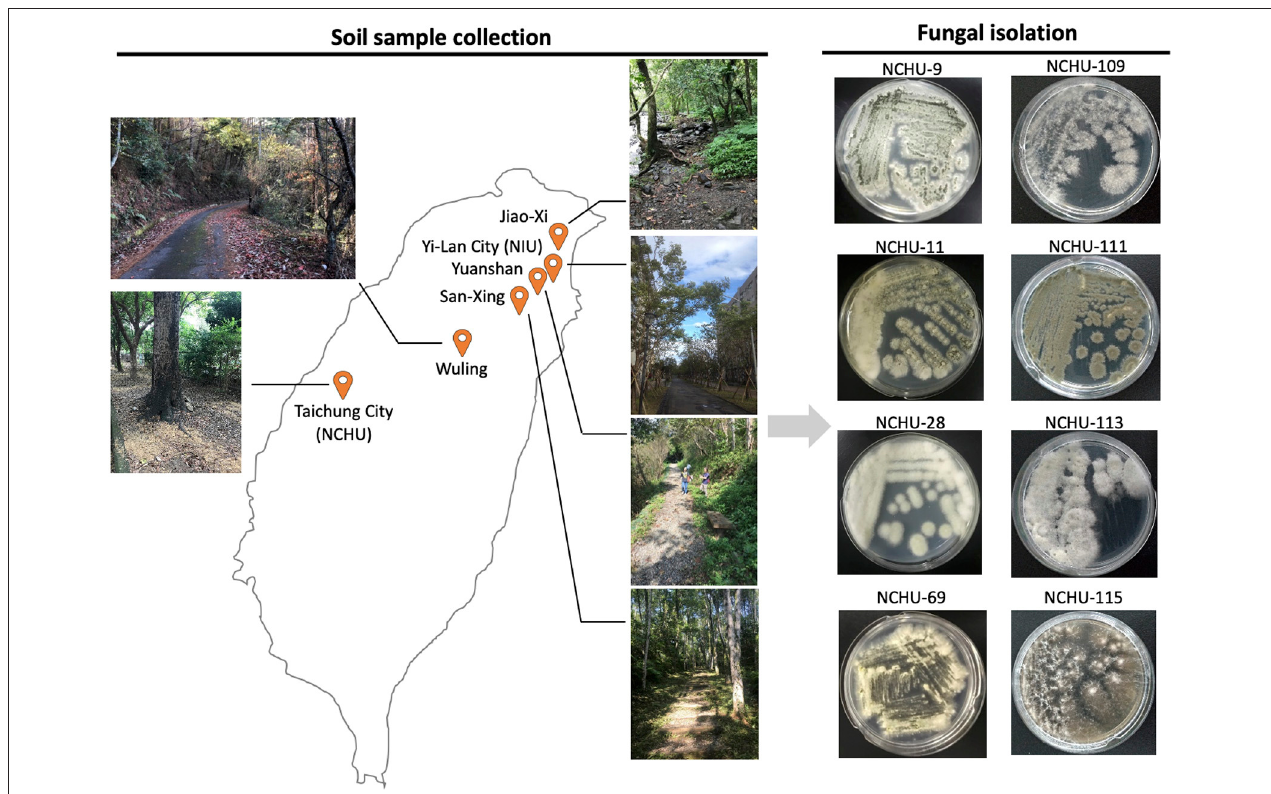
FIGURE 1 | Locations of soil sample collections and illustration of fungal isolation and pathogenicity screening using mealworms. The entomopathogenic fungal isolates were designated the National Chung Hsing University Entomopathogenic Fungi (NCHU), and the fungal collection library was